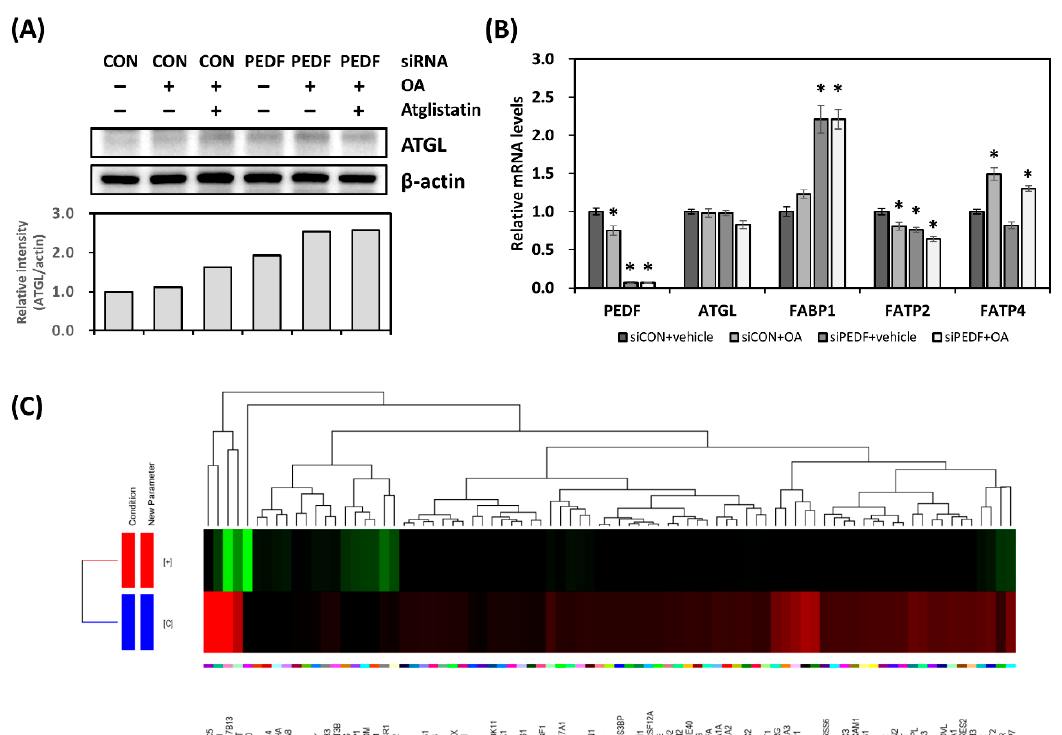
Figure 4. Decreased PEDF results in gene expression changes toward hepatic lipid accumulation. ( A ) Control and PEDF siRNA transfected Hep3B cells were treated with OA (0.1 mM) or OA + Atglistatin (25 µ M) for 24 h. Adipose triglyceride lipase (ATGL) protein levels were determined using immunoblotting. ATGL band intensity was quantified and normalized to that of β -actin. ( B ) Gene expression was determined using quantitative RT-PCR. ( C ) Hierarchical clustering dendrogram showing non-alcoholic fatty liver disease (NAFLD)-related di ff erentially expressed genes (DEGs) by comparing control with PEDF siRNA transfected Hep3B samples. *, Statistically significant compared with the controls at p <